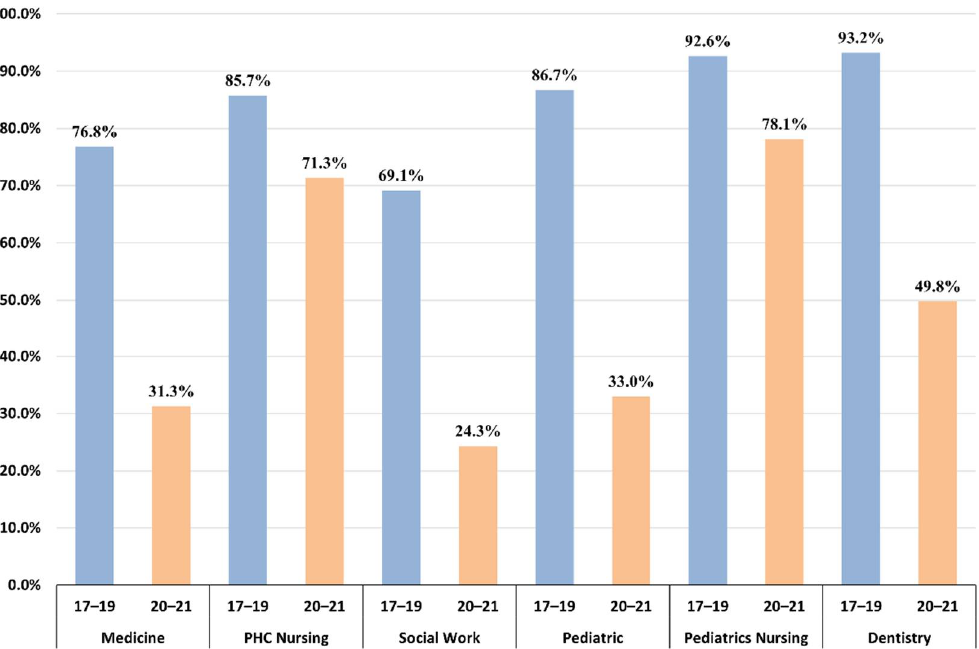
Figure 1. Proportions of face-to-face consults in 2017–2019 and 2020–2021 by type of PHC professional.